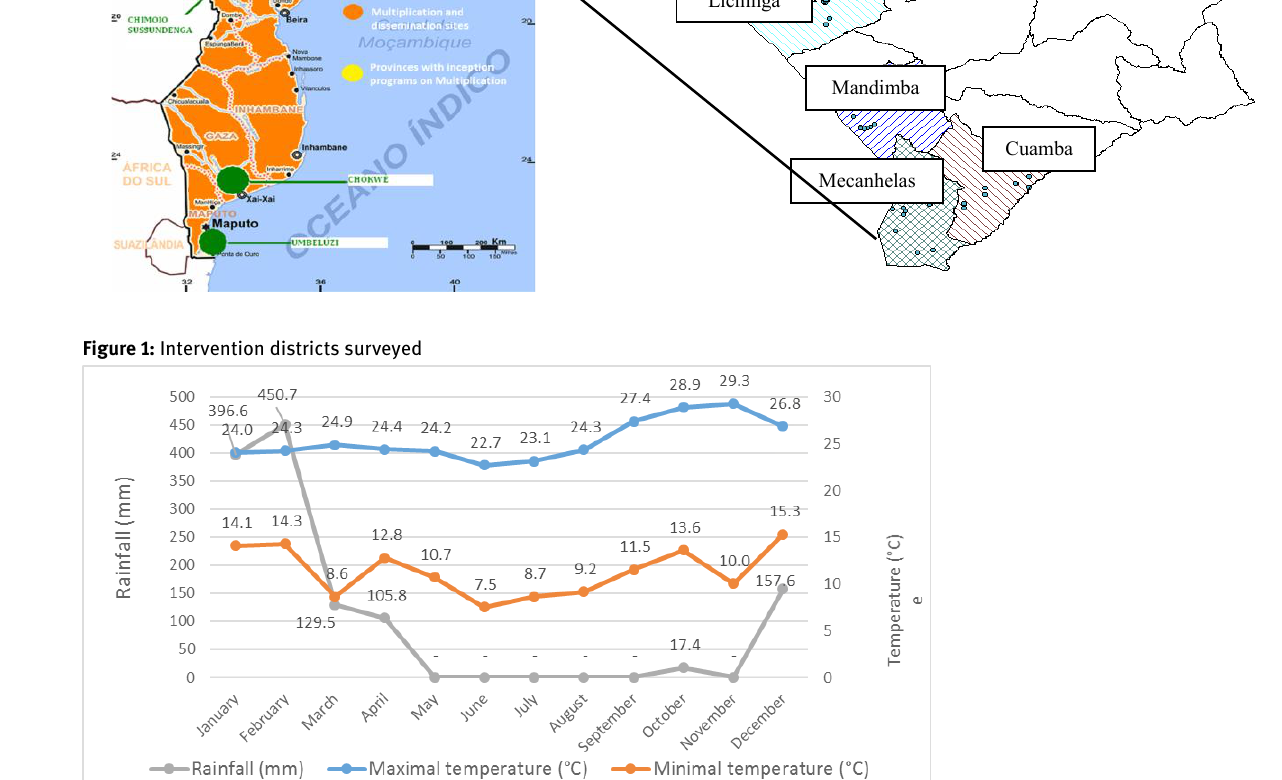
Figure 2: Temperature (°C) and rainfall (mm) in